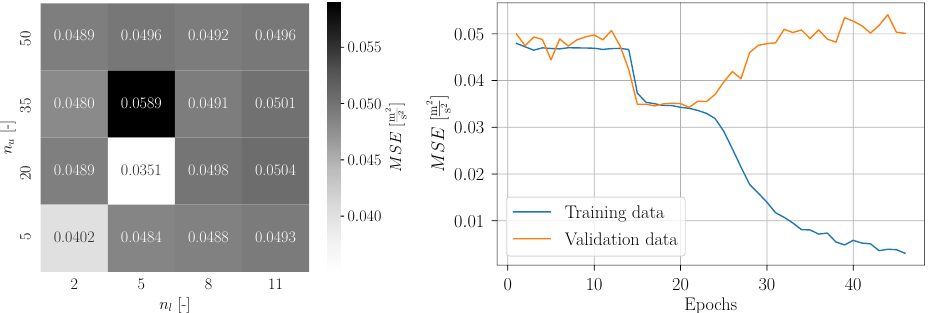
Figure 36. Visualization of the grid search results ( left ) and the learning curve of a subsequent training for n l = 5 and n u = 20 ( right